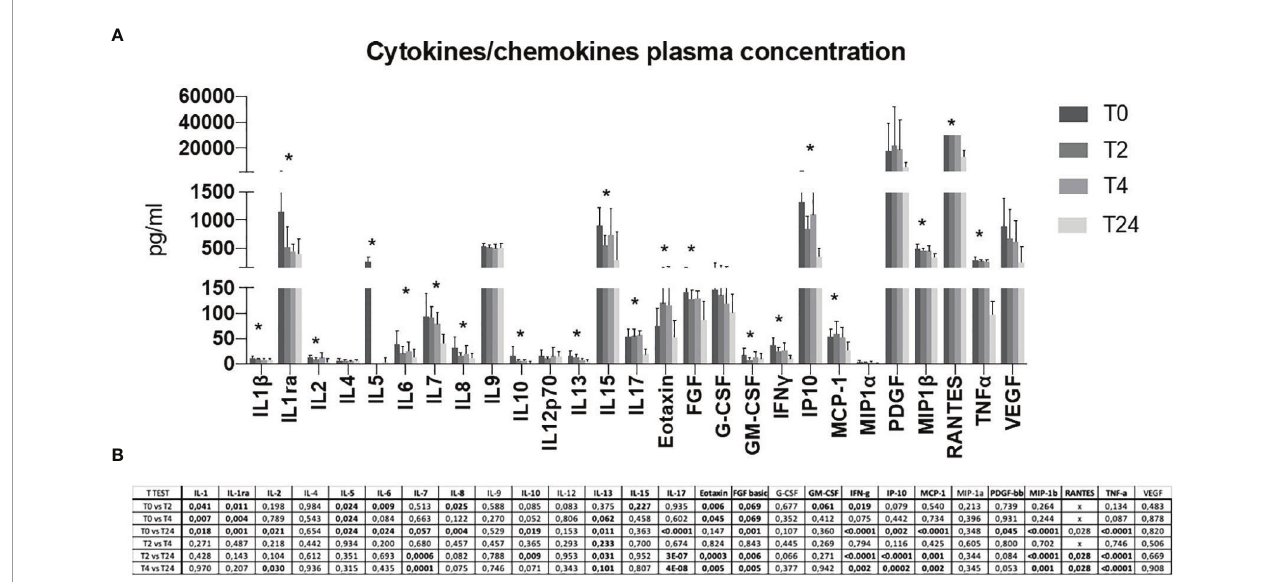
FIGURE 4 | A 27 cytokine/chemokine multiplex array was performed on a maternal plasma at T0, T2, T4 and T24 (A) . Protein concentration is shown as pg/ml. Statistical signi fi cance obtained by multiple t Test analyses is reported in (B) . p ≤ 0.05 values are highlighted in bold. * p ≤